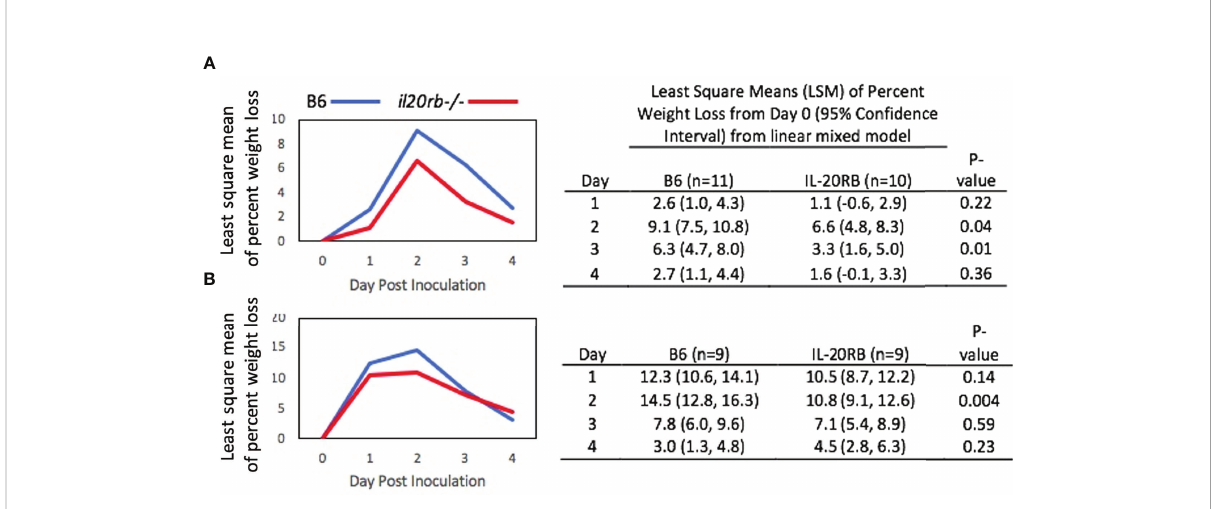
FIGURE 3 Percent weight loss relative to Day 0 in il20rb-/- and WT B6 mice after inoculation with C. albicans CAF2-1. Mice de fi cient in the IL-20RB receptor (red) exhibit reduced weight loss during oral candidiasis compared to WT B6 mice (blue), matched for age and gender. Low-dose cortisone (15 mg/kg) was used in the experiment shown in (A) but not in (B) . The mean percent losses in body weight in il20rb-/- mice were lower than those of WT B6 mice on Days 2 and 3 in part A and on Day 2 in part (B) See the Materials and Methods section for a description of the statistical analysis. The raw data are provided in Supplementary Table